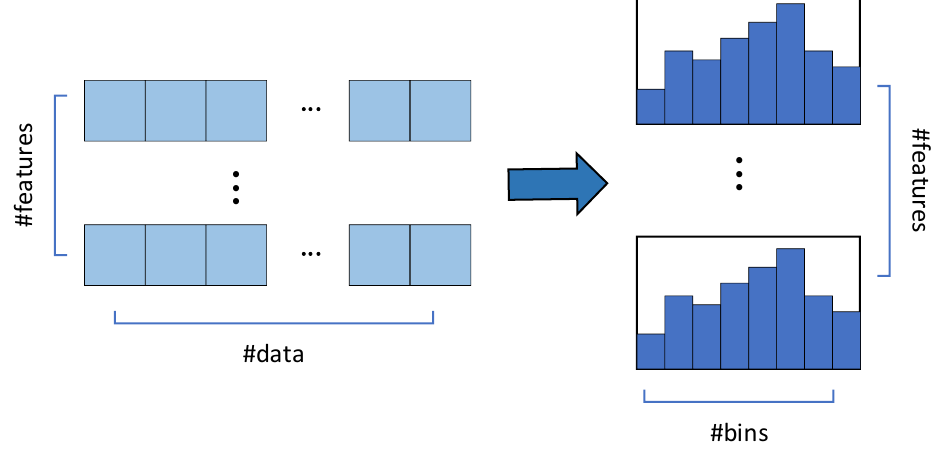
Figure 3. Histogram division of LightGBM.